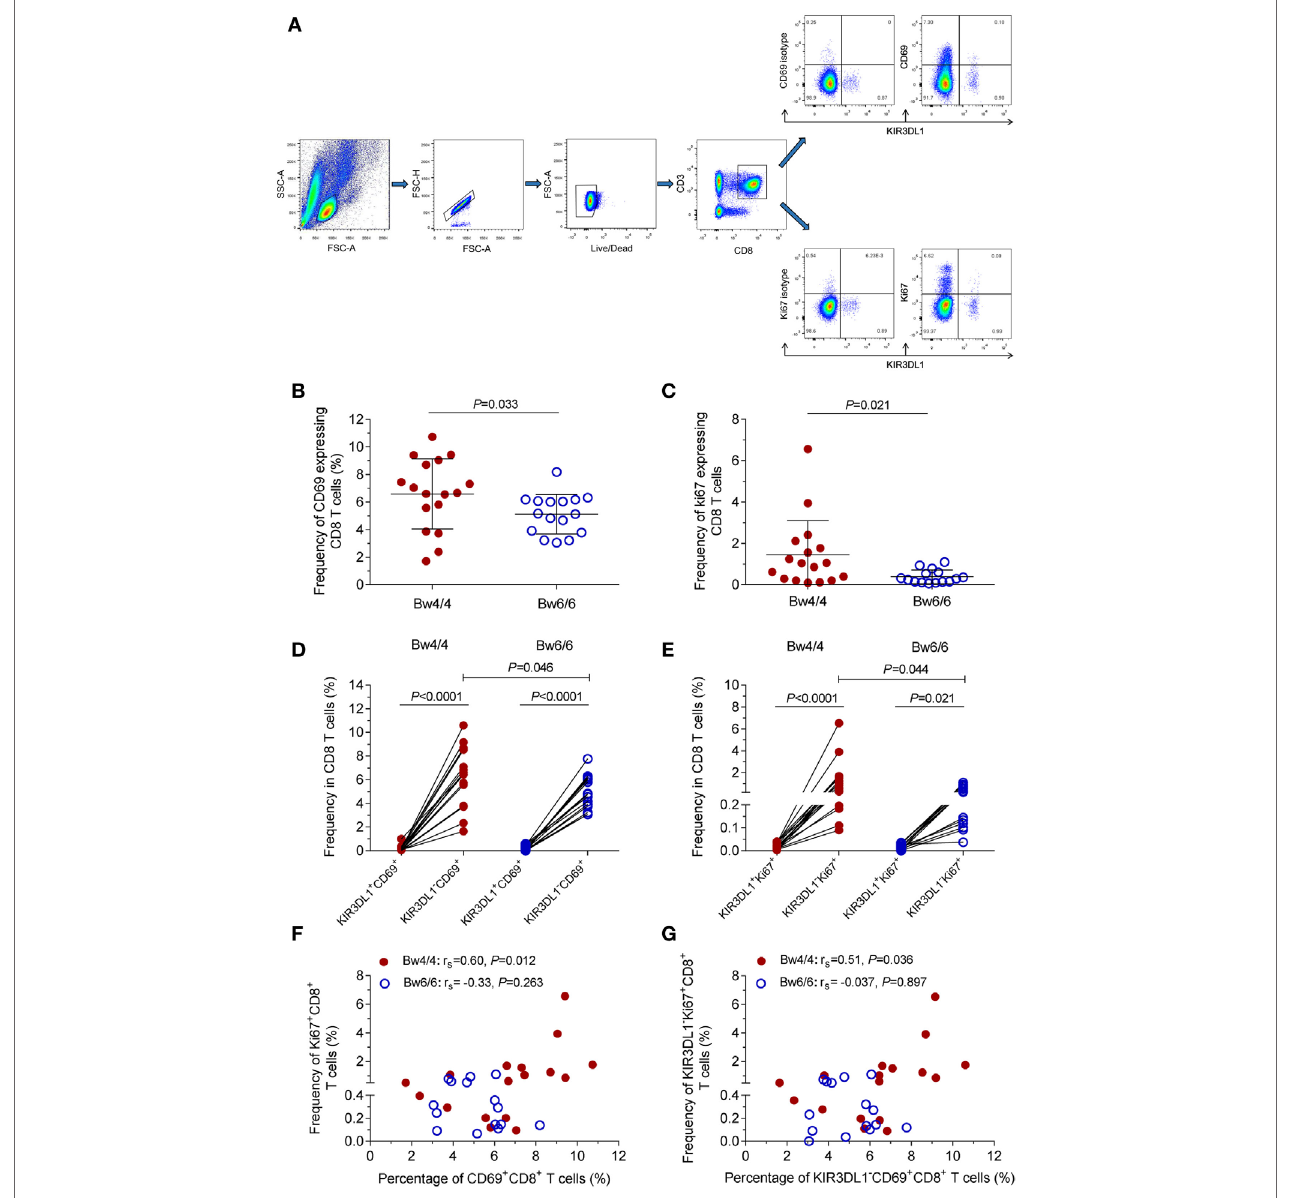
FigUre 4 | Early activation and proliferation of CD8 T cells in individuals with different HLA-B serological genotypes. (a) Gating strategy for flow cytometric analysis of CD69 and Ki67 expression on CD8 T cells; (B) early activation capacity of CD8 T cells; (c) proliferation capacity of CD8 T cells; (D) proportion of KIR3DL1 + CD69 + cells and KIR3DL1 − CD69 + cells in total CD8 T cells; (e) proportion of KIR3DL1 + Ki67 + cells and KIR3DL1 − Ki67 + cells in total CD8 T cells. Relationship between the early activation and proliferation capacity of total CD8 T cells (F) and KIR3DL1 − CD8 + T cells (g) . Comparisons between two groups were performed with unpaired Student’s t -tests, and correlations between two variables were analyzed in Spearman’s rank correlation tests, with P < 0.05 considered significant.